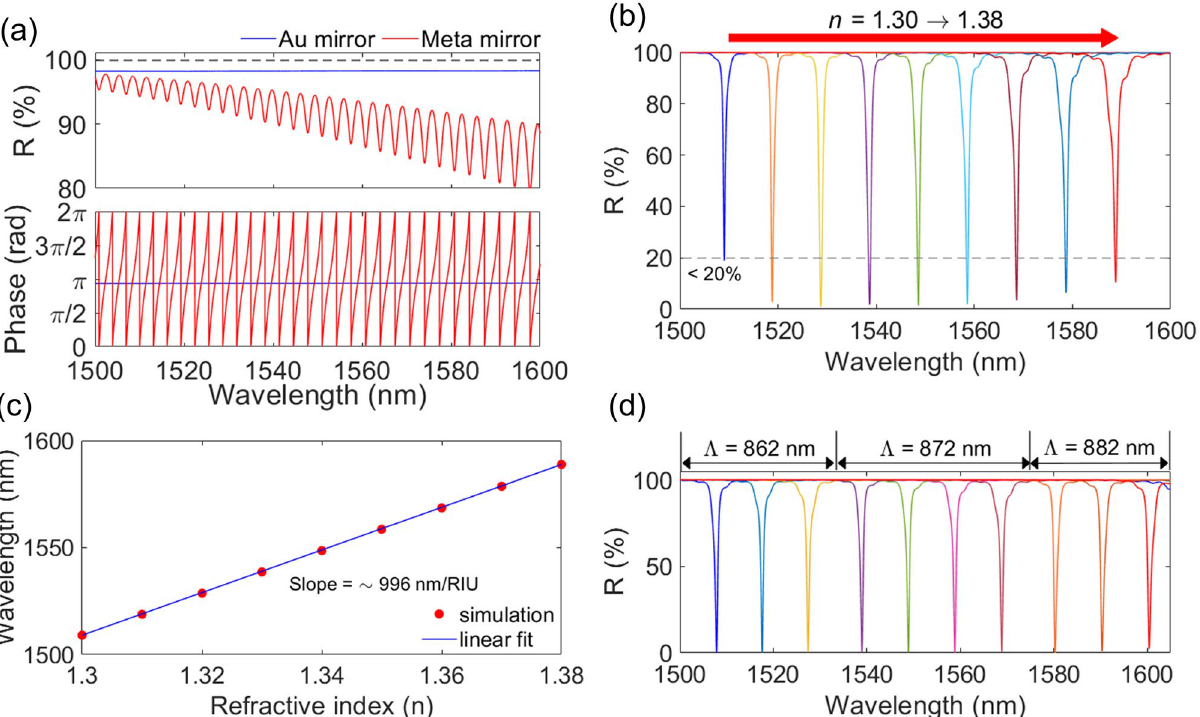
Figure 5. ( a ) Reflectance and phase spectra of the metasurface on a glass substrate and the bottom Au mirror. ( b ) Reflectance spectra of the liquid sensor by varying the refractive index of liquid from 1.30 to 1.38 in steps of 0.01. ( c ) The extracted dip position (red dots) of the liquid sensor for each reflectance spectrum and the estimated slope (blue solid line) of ~ 996 nm/RIU. ( d ) Reflectance spectra of the liquid sensor with three different periods of 862, 872, and 882 nm covering the refractive index range from 1.30 to 1.39 in steps of 0.01. All the results are obtained from numerical